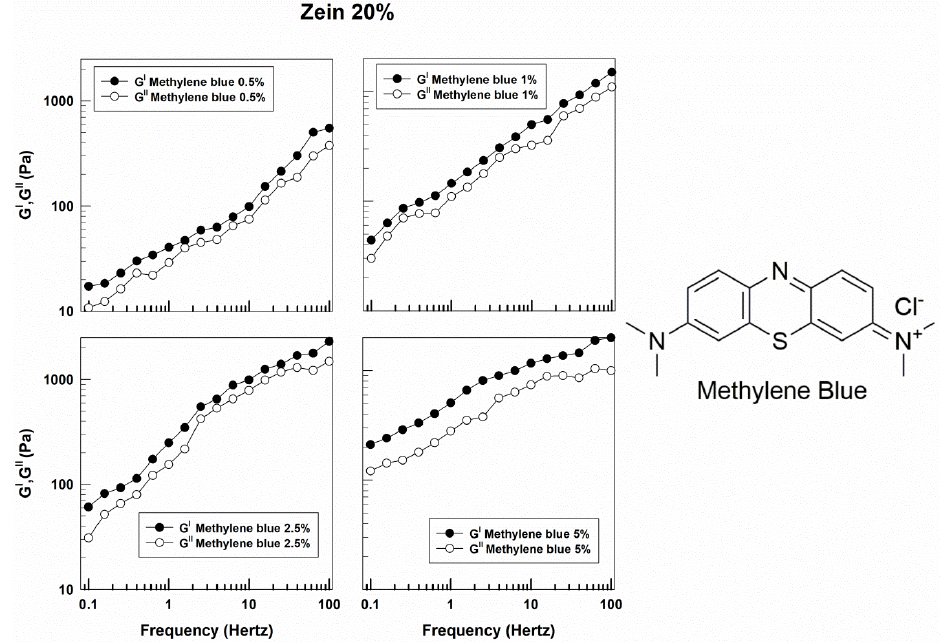
Figure 8. Evaluation of the elastic (G (cid:48) ) and viscous (G”) moduli of zein gels prepared using 20% w / v of protein and containing methylene blue (0.5%, 1%, 2.5%, 5% w / w ) as a function of the